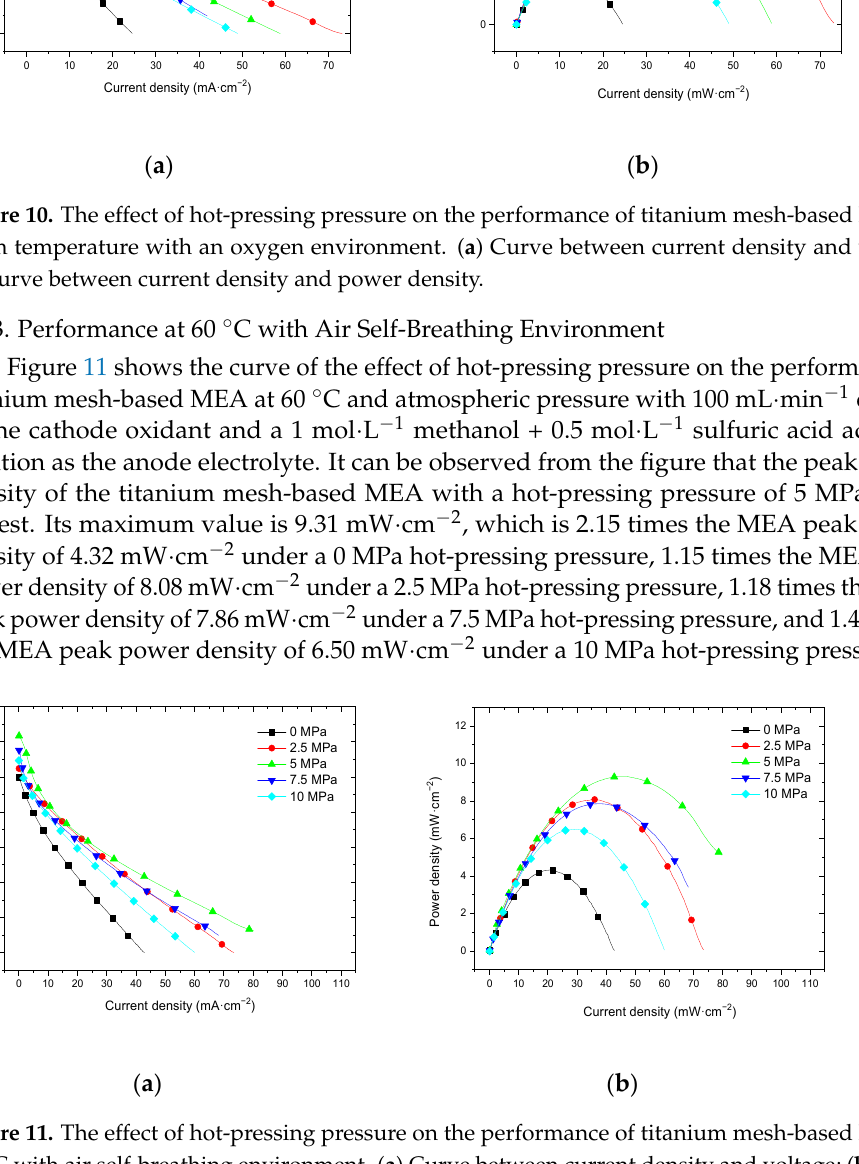
age; ( b ) curve between current density and power density.